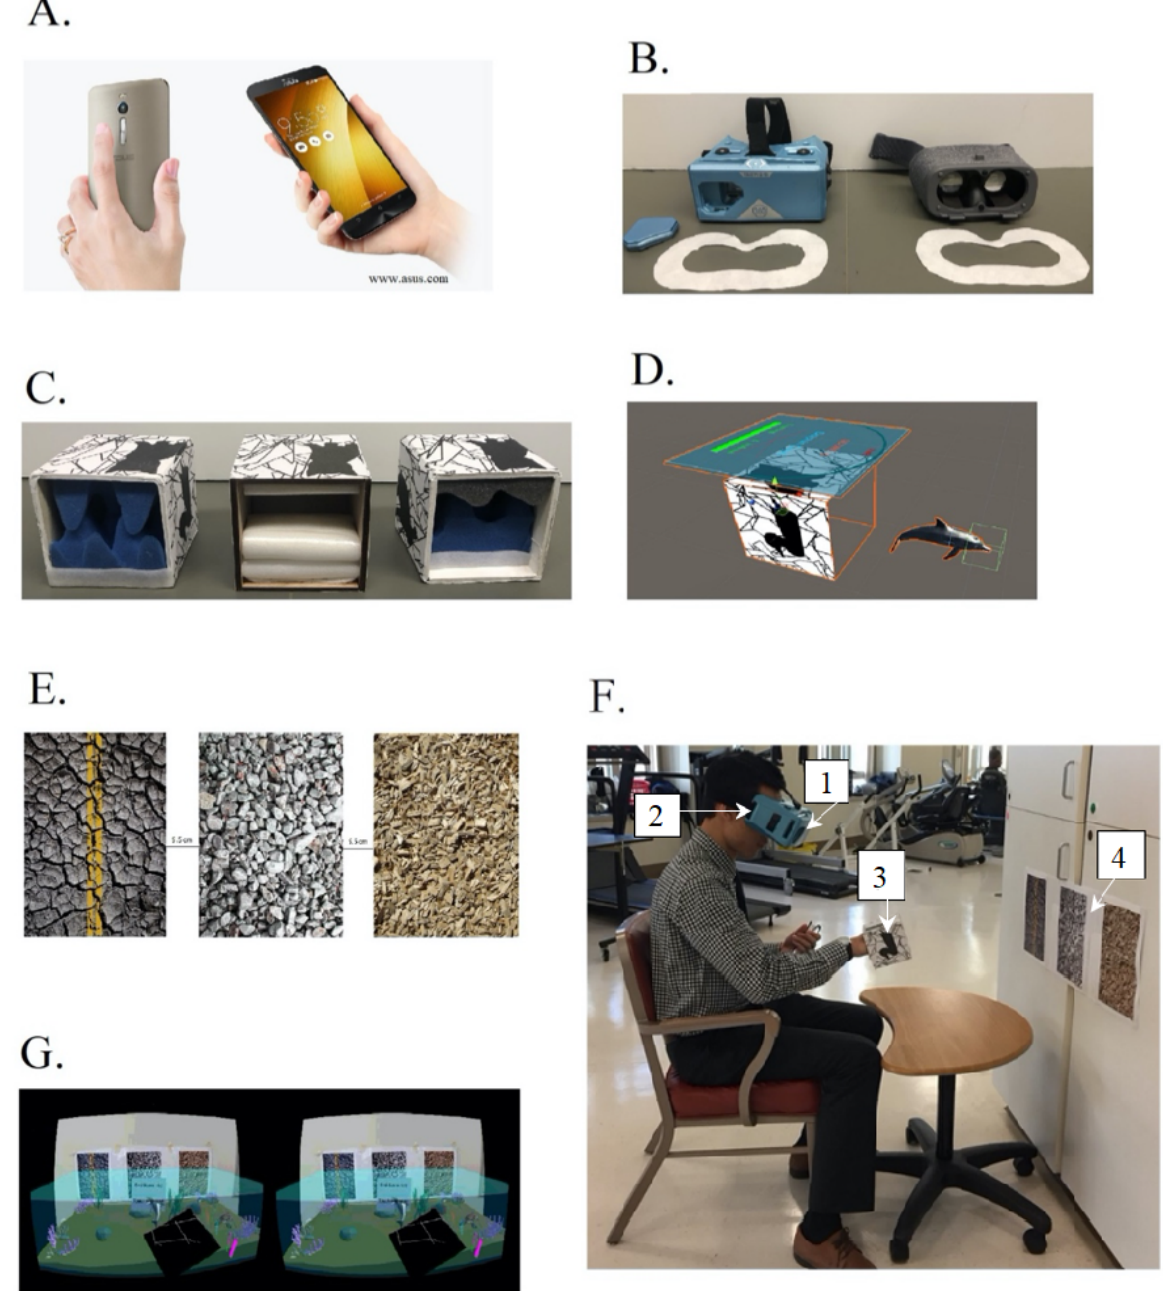
Figure 1. (A) phone: Asus Zenfone 2, phone operating system: Android 7 Nougat, Unity version: 2018.2.10, developer operating system: Windows 10; (B) headsets: Google Daydream (left) Merge augmented reality/virtual reality goggles (right); (C) controllers with various grip sizes consisting of soft foam inserts; (D) virtual dolphin avatar; (E) image target; (F) study staff during game play with (1) smartphone (2) headset (3) controller (4) image target; (G) user